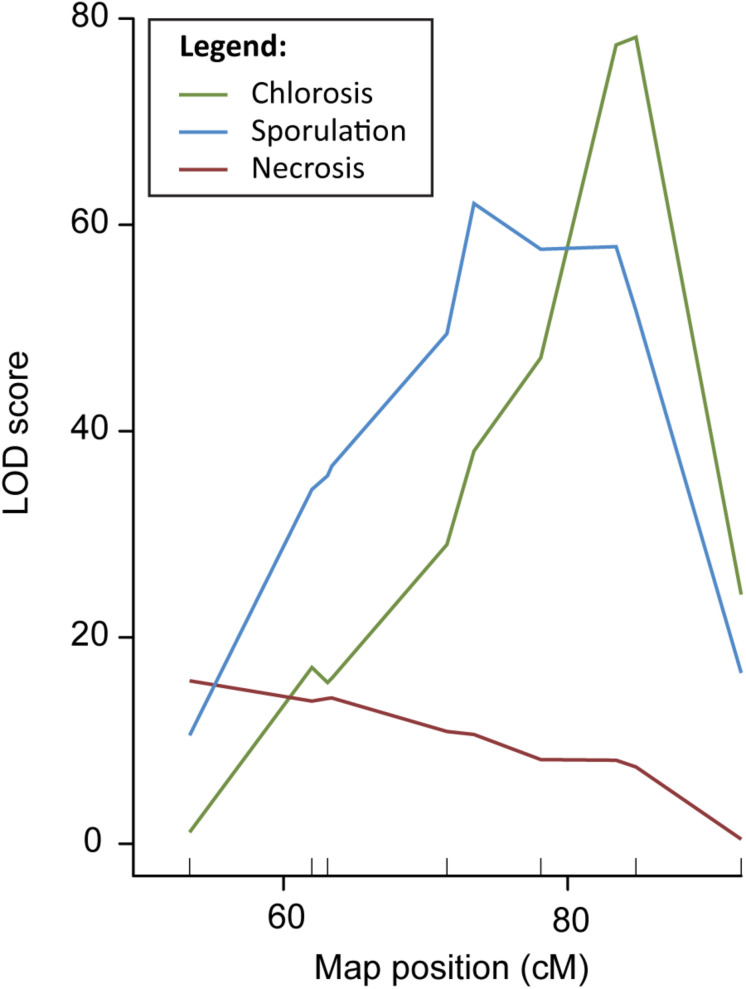
QTL analysis DM resistance within the DM4.1 interval based on multiple disease phenotypes. QTL analysis was carried out in a population consisting of 19 recombinant families derived from a QTL isogenic introgression line. The mapping population was scored for chlorosis, sporulation, and pathogen-induced necrosis, and genotypes with seven SNP markers in the DM4.1 interval. Two SNP markers flanking this interval were not polymorphic, as the progenitor of the mapping population was fixed for these alleles.